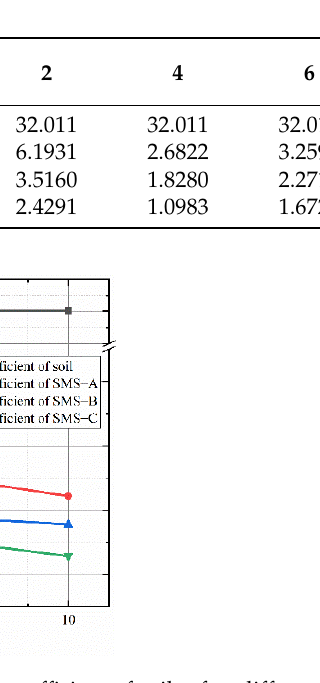
Figure 13. Changes in permeability coefficient of soils after different hydrophobic treatments.